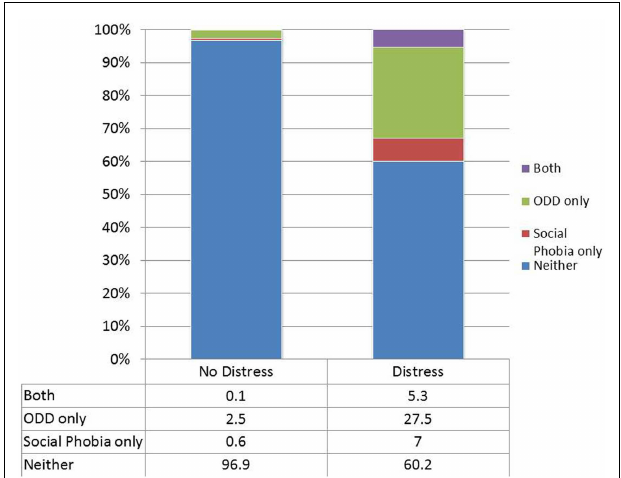
FIGURE 2 |The overlap between oppositional defiant disorder and social phobia as a function of the distress disorder category